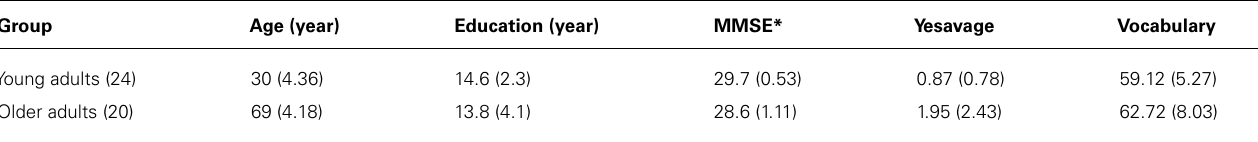
Table 1 | Mean scores of screening tests for the two groups and mean years of formal education (SD in parentheses).